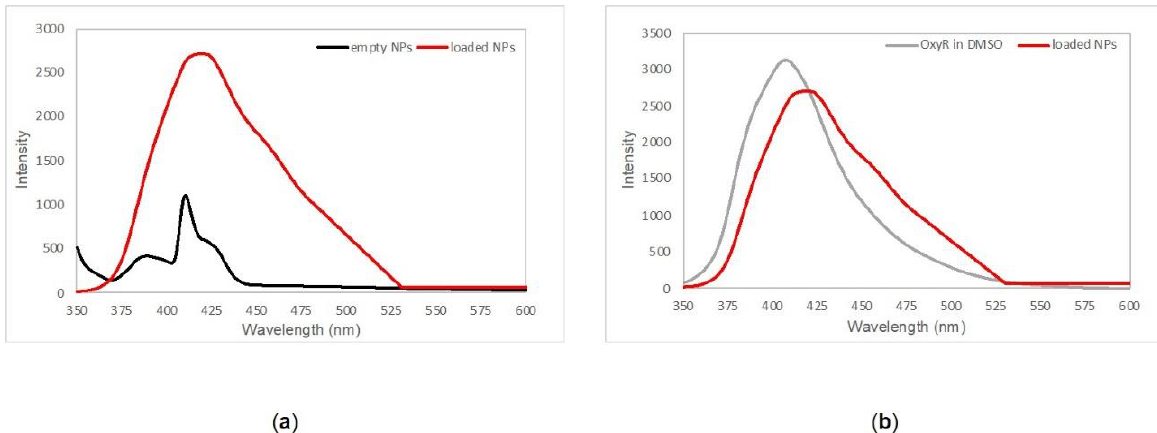
Figure 1. ( a ) Emission spectra of empty PLGA nanoparticles (black line) and oxyresveratrol-loaded PLGA nanoparticles (red line) collected in phosphate buffer saline pH 7.4. ( b ) Overlapping between free oxyresveratrol emission pattern in DMSO (gray line) and oxyresveratrol encapsulated in PLGA nanoparticles (red line).